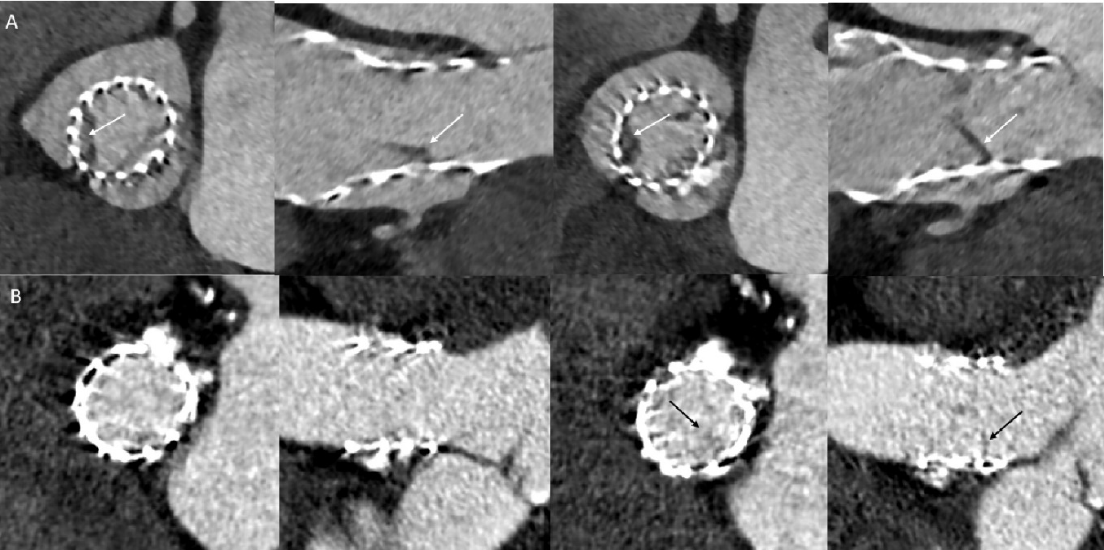
Figure 1. Examples of prostheses with Hypoattenuated Leaflet Thickening (HALT). ( A ) HALT (white arrows) depicted in systole (left) and diastole (right) ( B ) HALT (black arrows) missed in systole (left), but depicted in diastole (right).